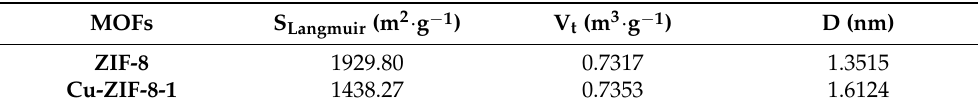
Table 1. Specific surface area, mesopore volume, micropore volume, and pore size of ZIF-8 and Cu-ZIF-8-1.